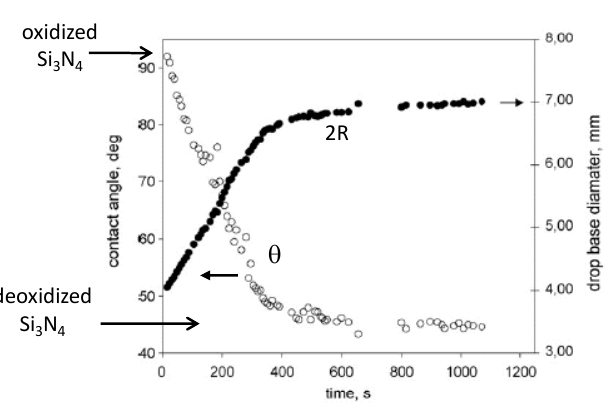
Figure 16. Wetting curves (contact angle and drop base diameter 2R vs. time) for liquid